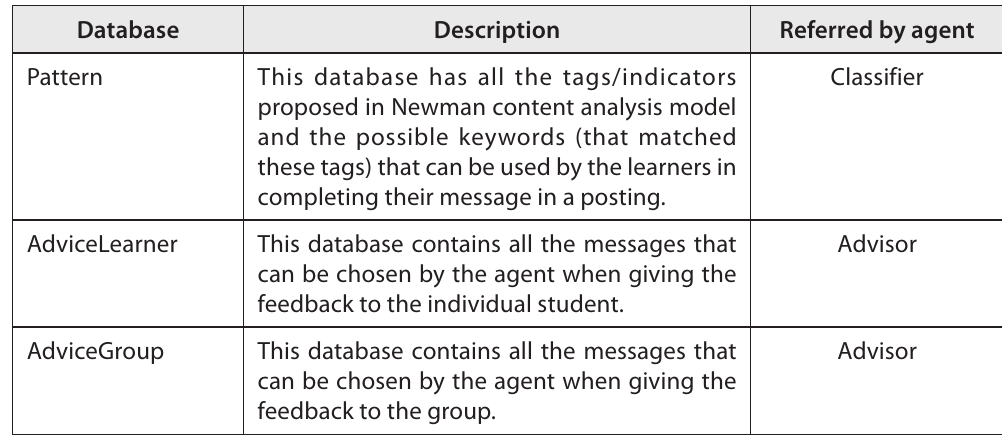
Table 2 Databases in the smart